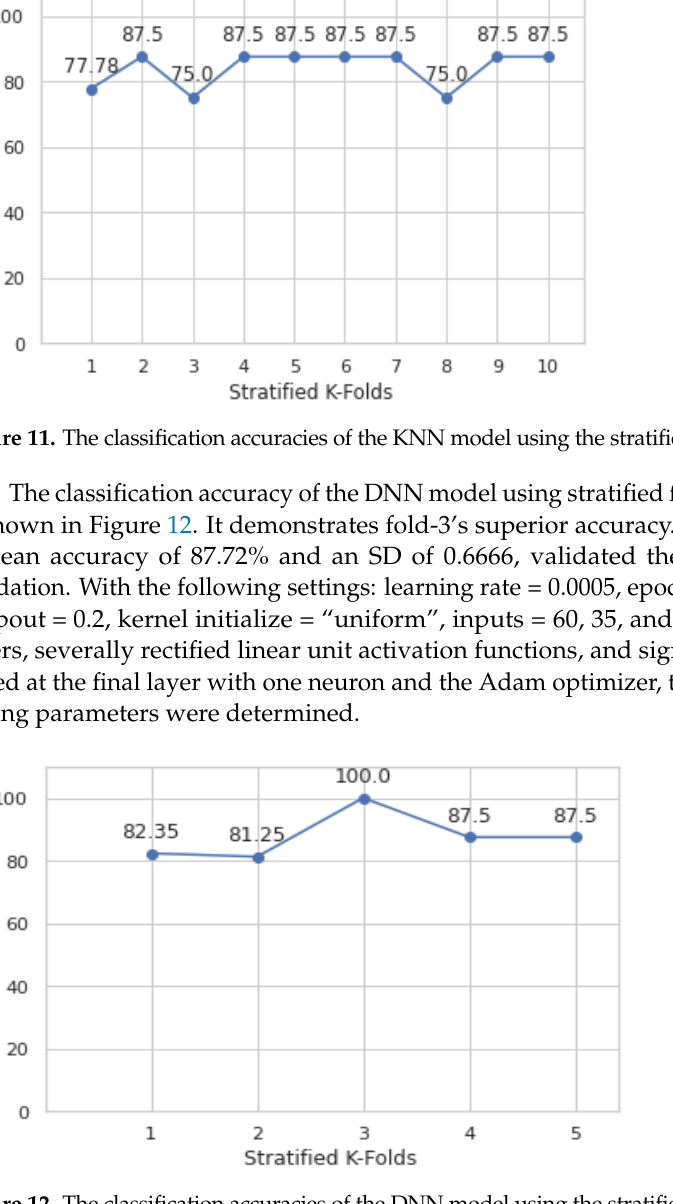
Figure 12. The classification accuracies of the DNN model using the stratified five-fold cross-valida- tion.